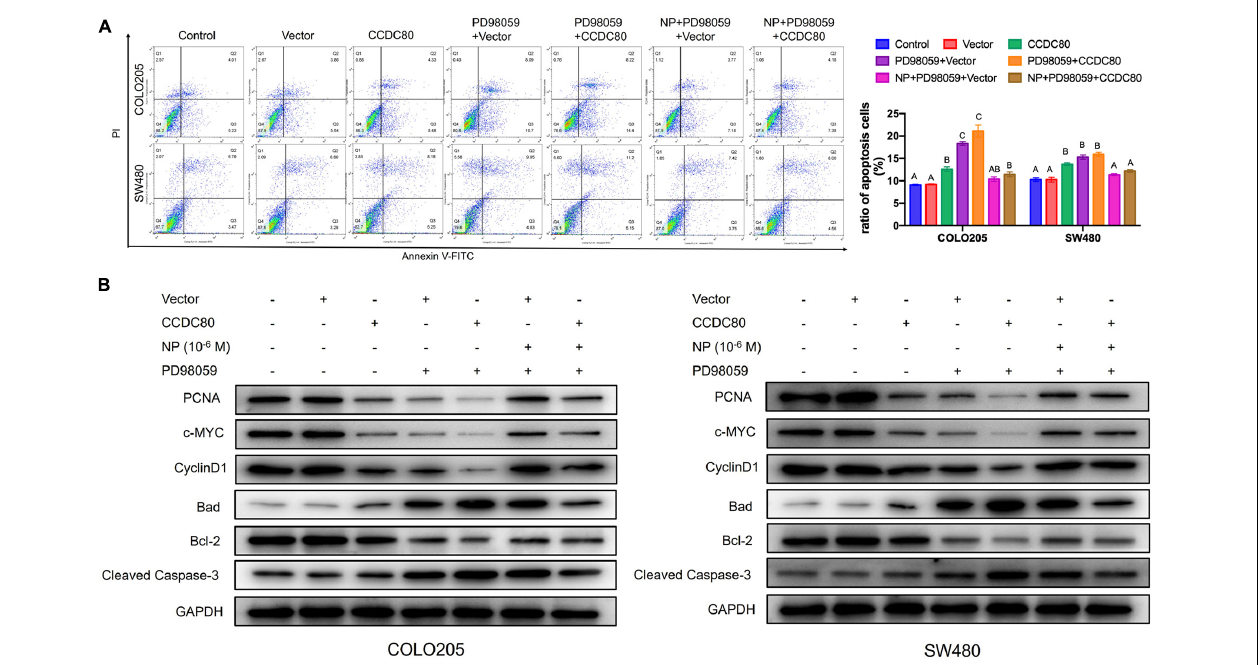
FIGURE 7 | Coiled-coil domain containing 80 (CCDC80) increases colorectal cancer (CRC) cell apoptosis by inhibiting ERK1/2 activity. (A) Cell apoptosis in treated cells analyzed using flow cytometry. (B) The expression of cell proliferation-related proteins (PCNA, c-MYC, and CyclinD1) and cell apoptosis-related proteins (Bcl-2, Bad, and Cleaved Caspase-3) in treated cells analyzed using western blot assay.